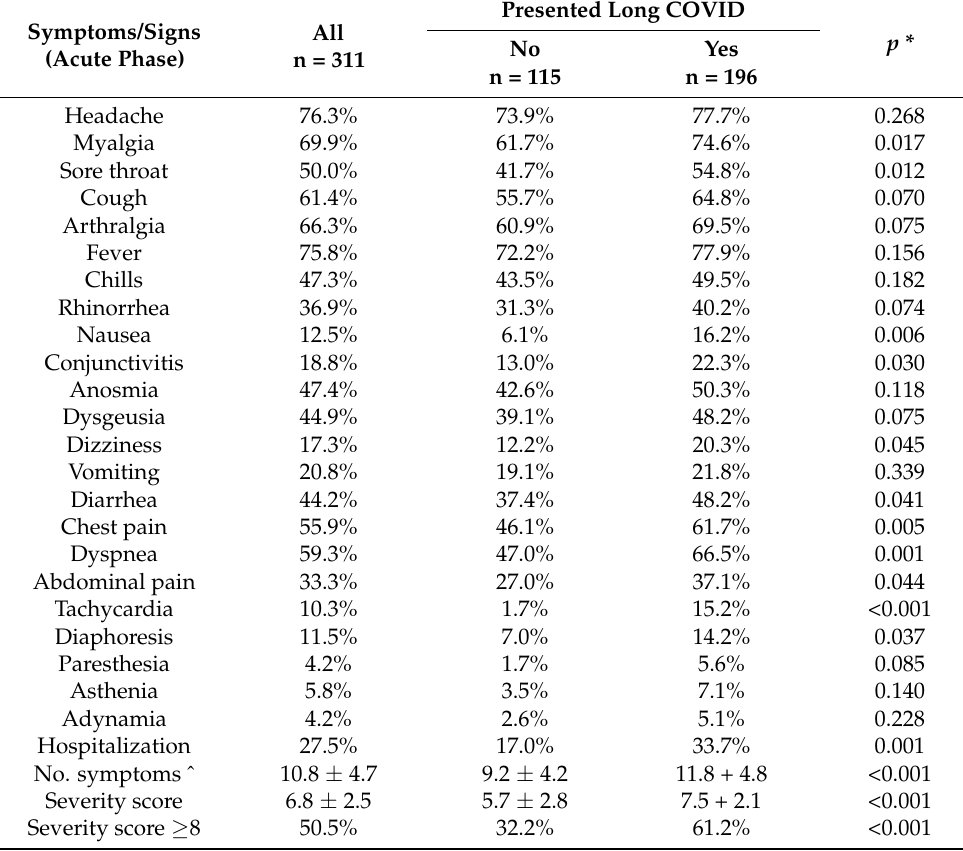
Table 3. Proportion of patients who presented diverse signs and symptoms of the disease in the acute phase according to whether they developed long COVID or